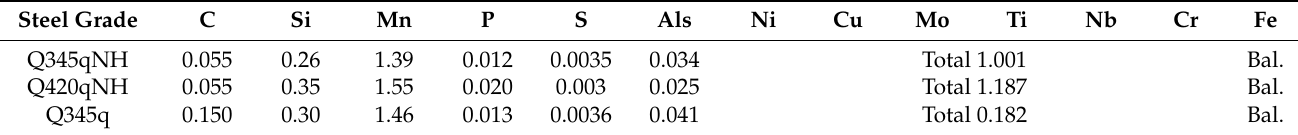
Table 2. Chemical compositions of steel grades. (Mass fraction wt.